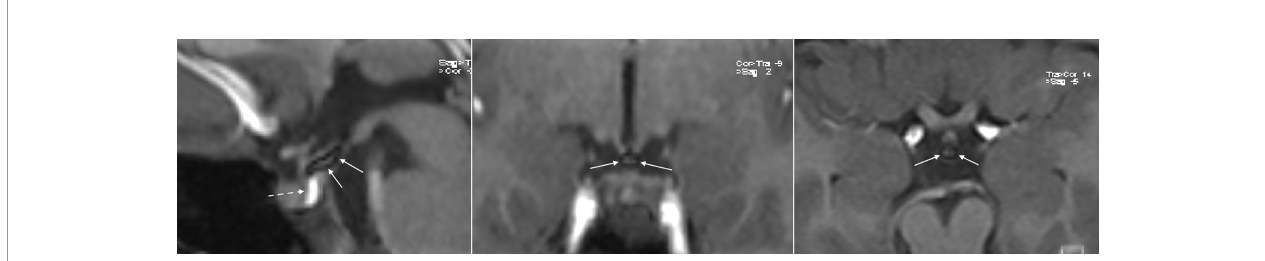
FIGURE 2 | 3D Fat Suppression T1w VIBE sequences (sagittal, coronal and axial from left to right) con fi rm the hypothesis of lipoma of the tuber cinereum, as the upper part of the “ unusual pituitary bright spot ” disappears, leaving a small hypointense central area most probably representing a fi brosus core (continuous arrows). The neurohypophysis remains unchanged as expected, normal in signal, shape, and size (dotted arrow).